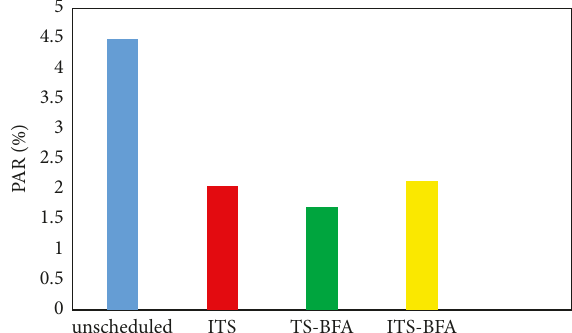
Figure 5: Total cost of electricity for a 24-hour day.